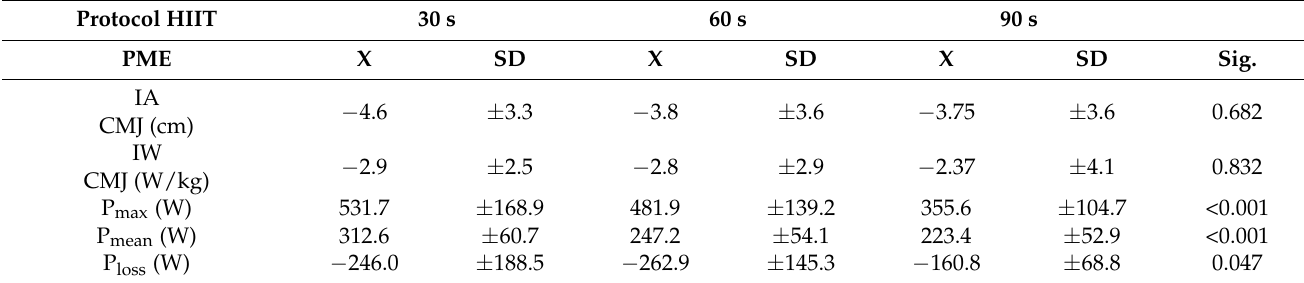
Table 2. Experimental physiological parameters chosen at the baseline for the 3 different training